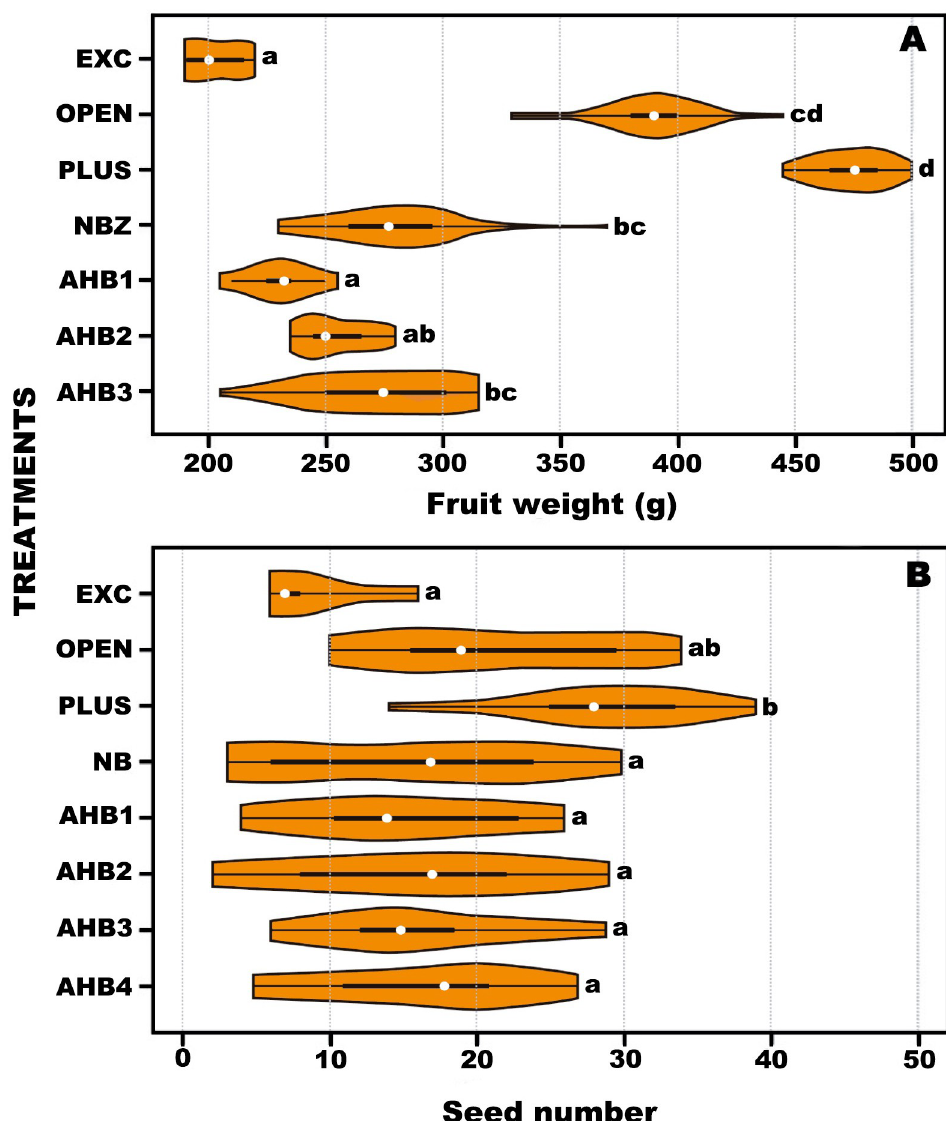
Fig 6. Violin plots comparing the weight of eggplant fruit (A) and seed number of annatto fruit (B) after the application treatments for controlled flower access (see text for acronyms). White circles show the medians; box limits indicate the 25th and 75 th percentiles as determined by R software; whiskers extend 1.5 times the interquartile range from the 25th and 75th percentiles. Different letters indicate significant differences among treatments at p <